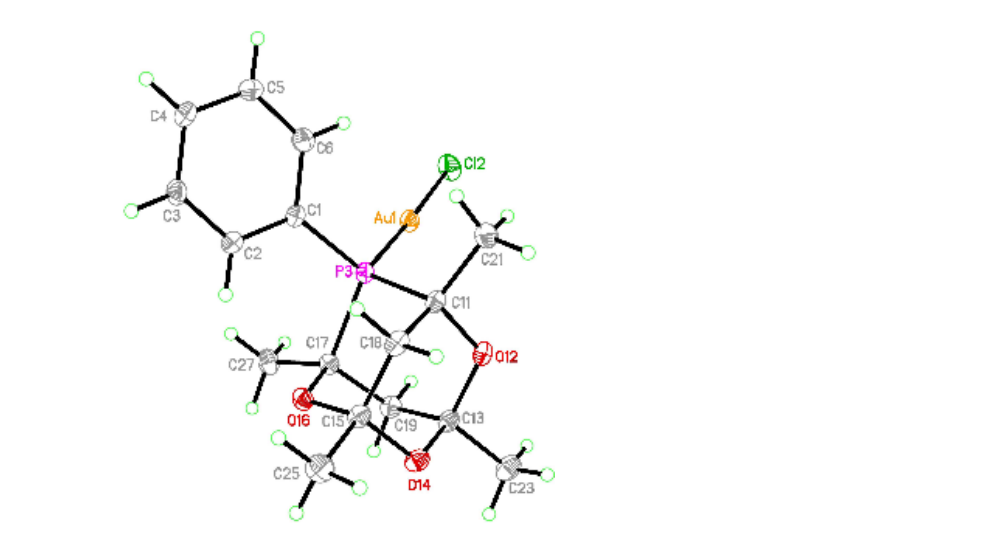
Figure 4. Structure of ( 3 ) with numbering scheme and thermal ellipsoids at 20% probability.